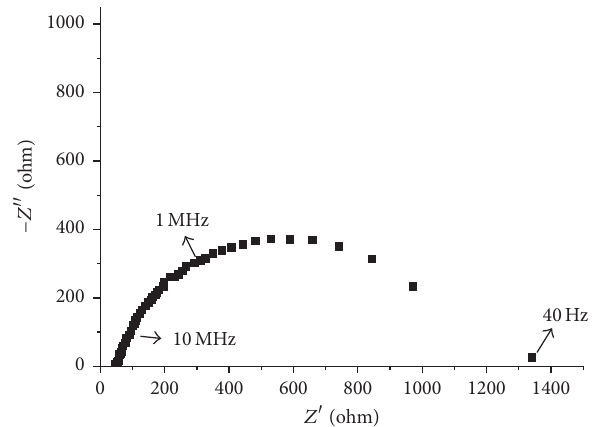
Figure 11: Nyquist plot of spectroscopy test results of specimen number C0.